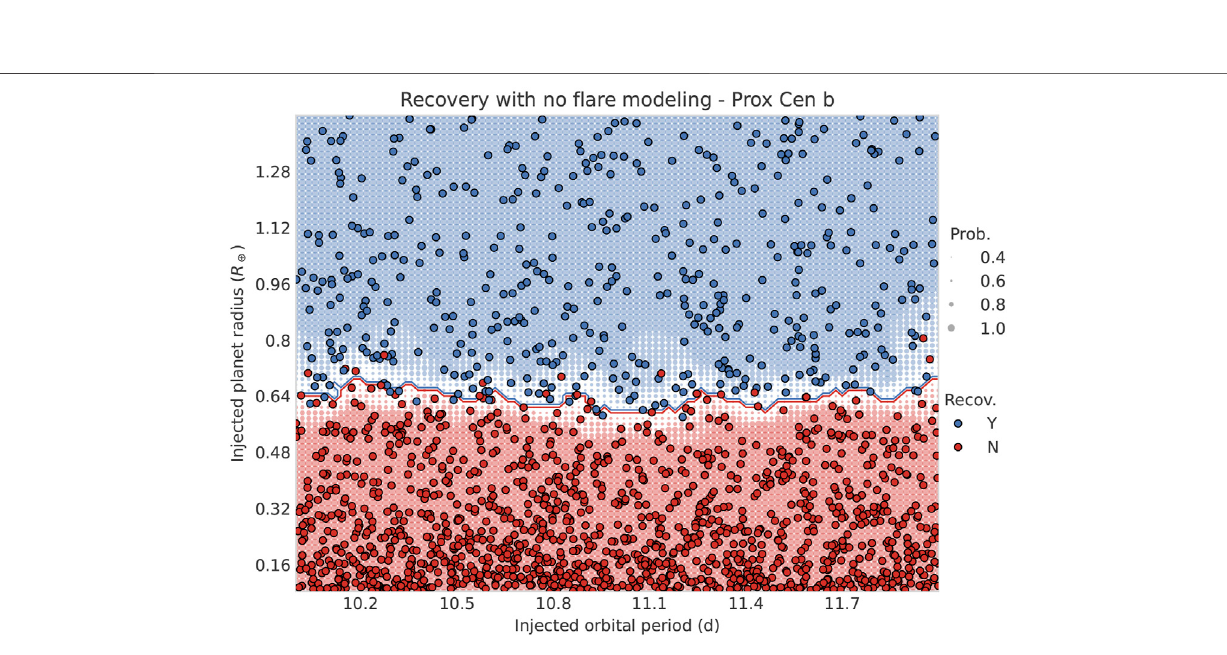
Frontiers in Astronomy and Space Sciences |